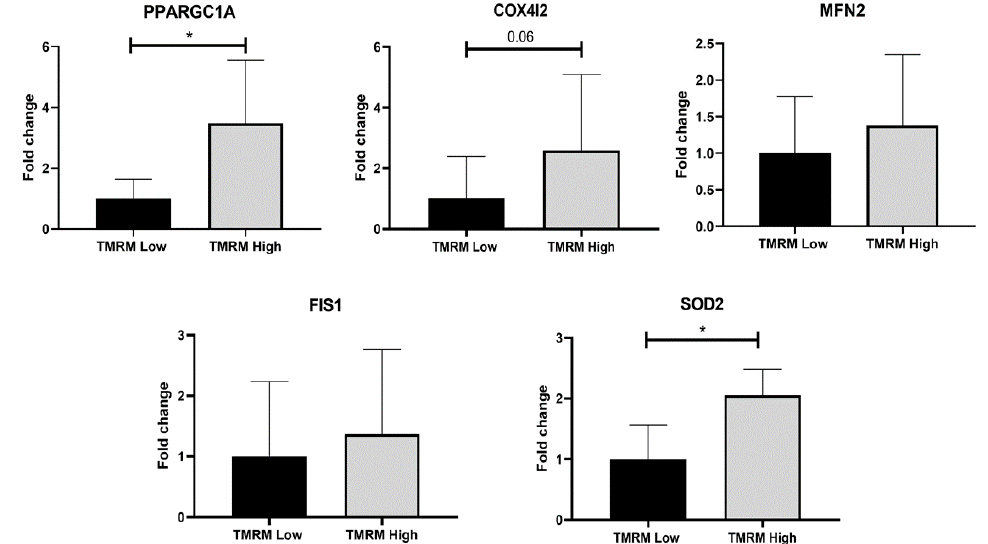
Figure 4. Mitochondrial gene expression in TMRM-low and high cells. mRNA levels were determined by qRT-PCR. PPARGC1A : Peroxisome proliferator-activated receptor gamma coactivator 1-alpha; COX4I2 : cytochrome c oxidase subunit 4I2; MFN2 : mitofusin 2; FIS1 : Fission, mitochondrial 1; SOD2 : superoxide dismutase 2. Data are represented as mean ± SD of the fold change. n = 5 per group. Statistical differences were calculated significant as * p < 0.05, determined by Student’s t-test.